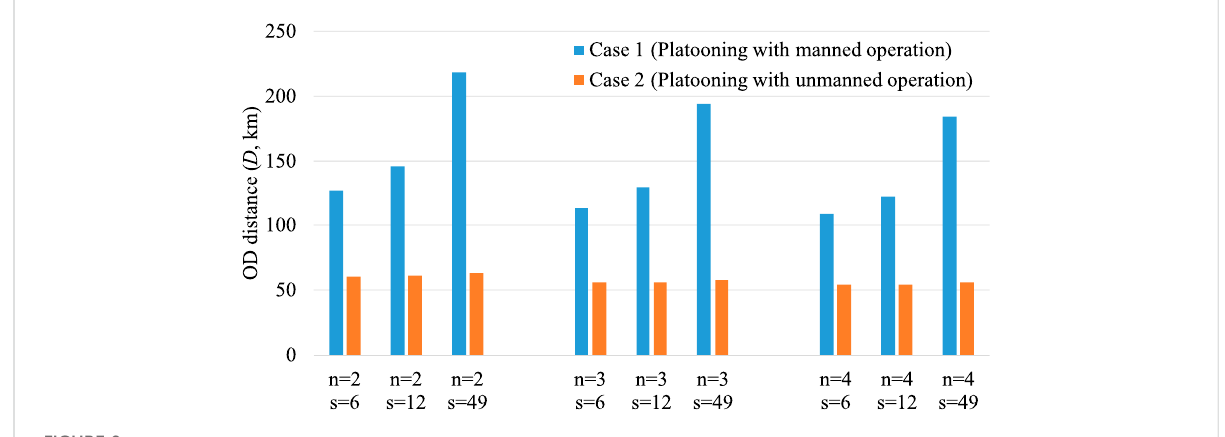
FIGURE 9 Minimumdistancebetweenoriginanddestination( D )at tf